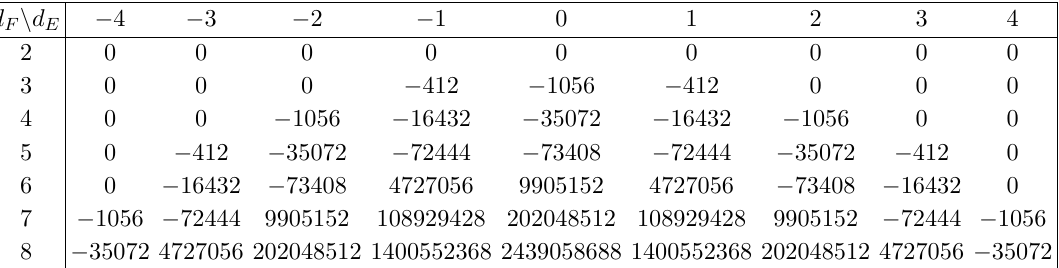
for ( F 4 ! F 1 )[SU(2) (cid:2) Z 2 ] (cid:0) 144 d F ;d E